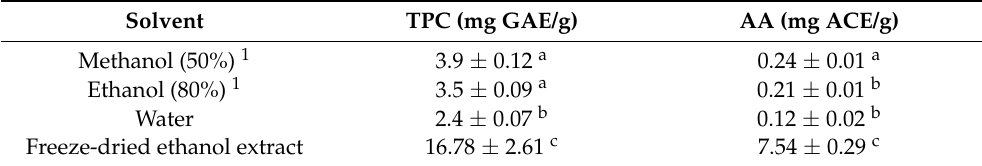
Table 1. Total phenolic content and antioxidant activity (AA) of Amaranthus cruentus sp. extracts in different solvents and after